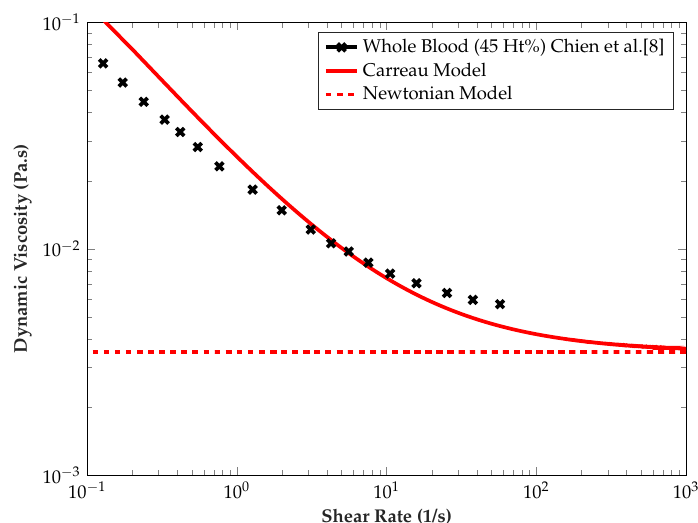
Figure 2. The Carreau model (red line) Equation (12) was used to replicate the behaviour of whole blood from Chien et al. [8] (black crosses). It was assumed that the Newtonian model had a constant viscosity equivalent to the infinite shear viscosity µ ∞ (red dashed line).